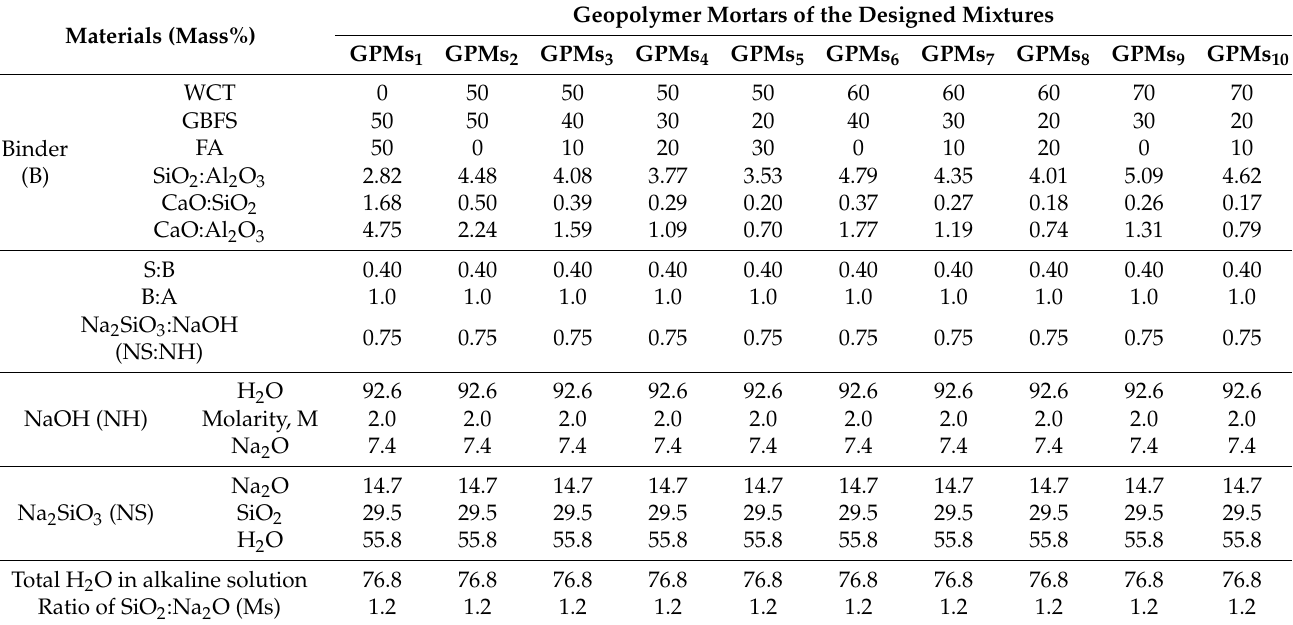
Table 3. Proposed GPMs mix design with various ratios of WCT:GBFS:FA. Geopolymer Mortars of the Designed Materials (Mass%)